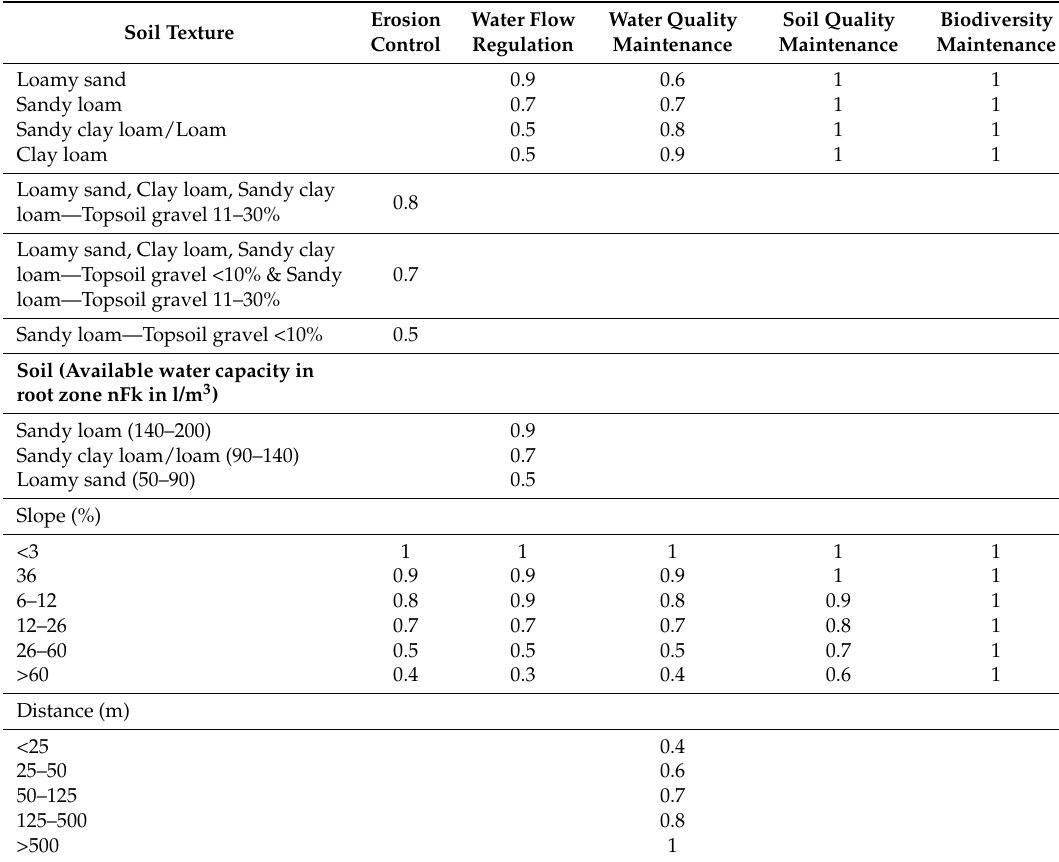
Table 3. Assigned values of landscape properties and ecosystem